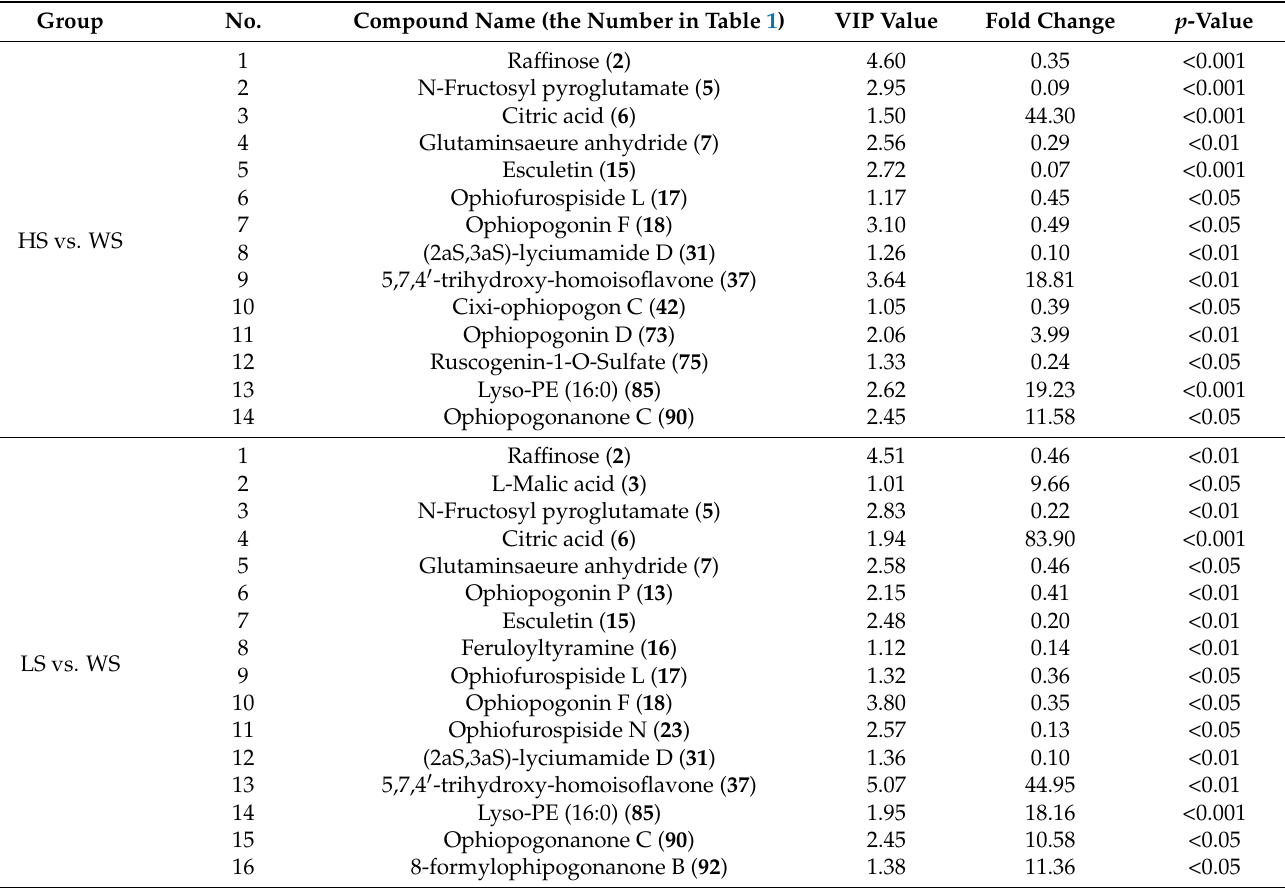
Table 1. The VIP value, Fold change and p -value of chemical